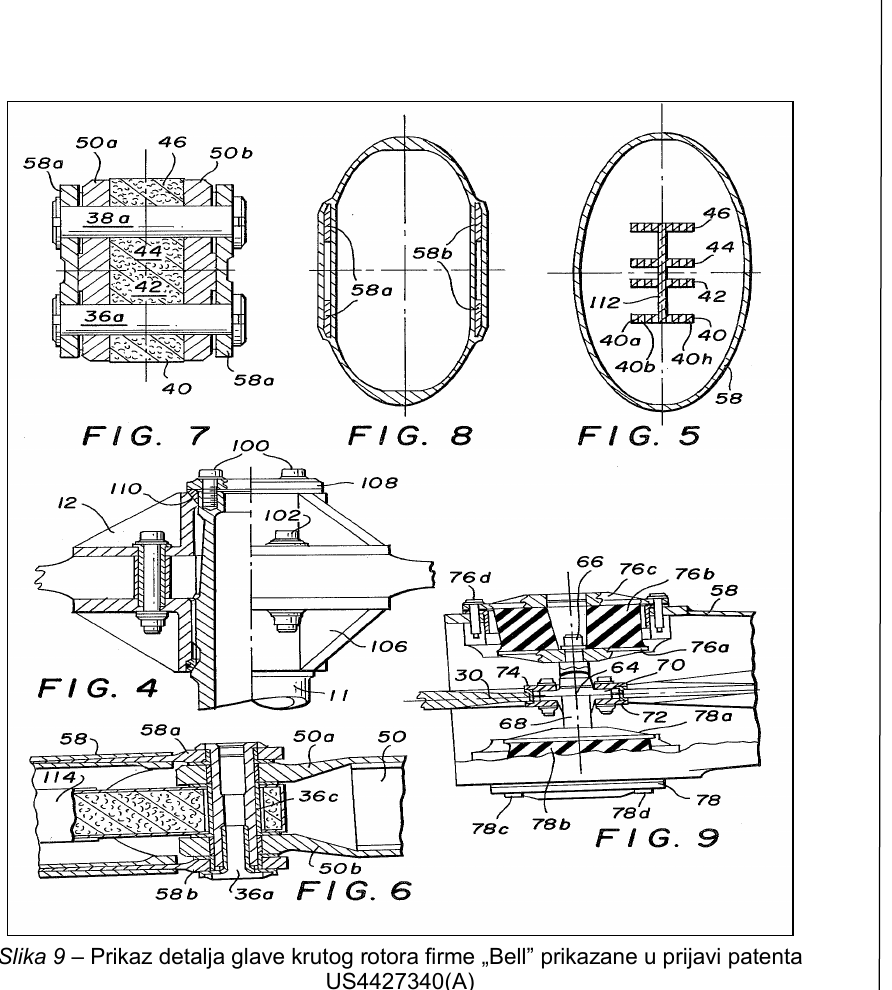
Figure 9 – Draft of the details of a rigid rotor head of the Bell company shown in patent US4427340(A) Рис . 9 – Чертеж деталей жесткого крепления лопастей к головке ротора компании Bell представлено в патенте US4427340 ( А ) U patentnoj dokumentaciji za prijavu US4427340(A) dati su svi